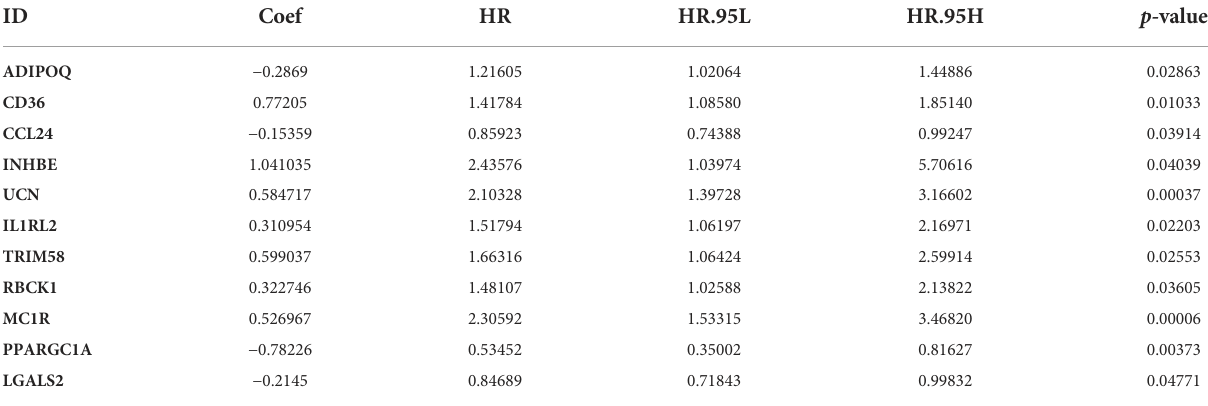
TABLE 1 The 11 immune-related hub genes used to compute the IRGPI risk